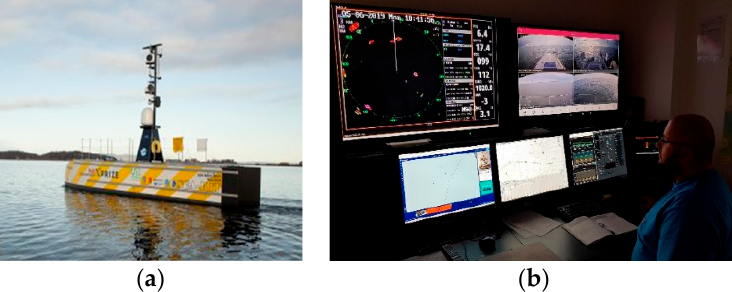
Figure 4. The first unmanned crossing from the UK to Belgium: ( a ) The ‘USV Maxlimer’—SEA-KIT type unmanned surface vessel [50]; ( b ) Master Mariner Karol Zwolak in the shore control station during the transit of the vessel (photo by Karolina Zwolak).